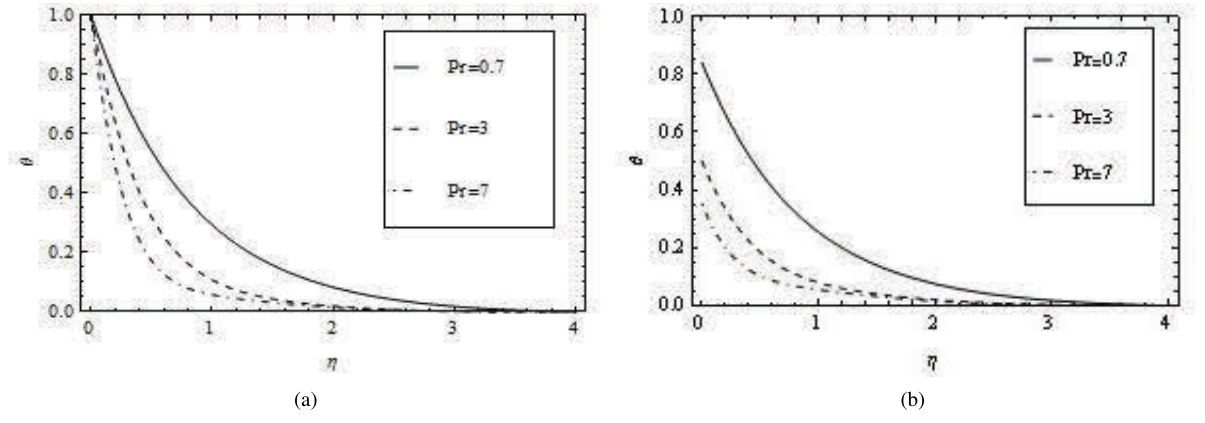
Figure 5. The effect of Prandtl number P r on temperature profiles when n D 1; ˇ D 0:5; (cid:21) 1 D (cid:21) 2 D 0:5; E c D 0:5 and k D 1:5 (a) for PST and (b) PHF cases.